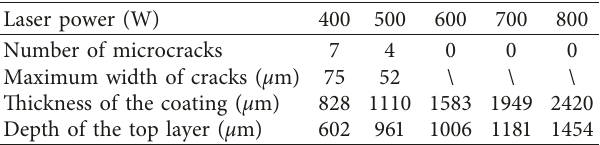
Figure 9: Microcracks in the coating prepared by overlapping laser tracks. Table 4: State of microcracks in the coatings with different laser power